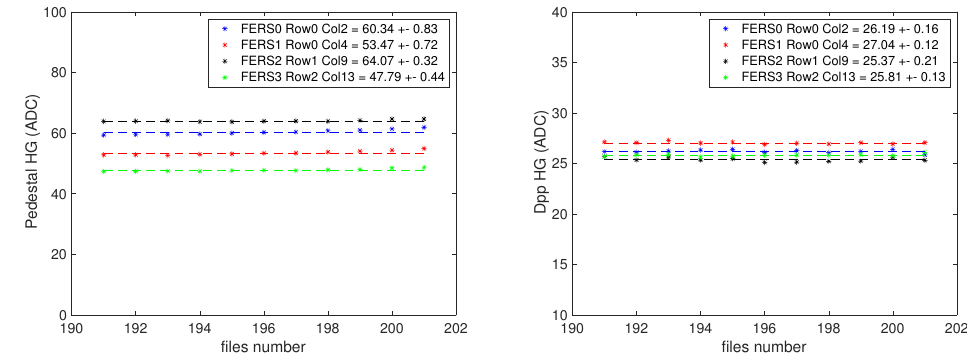
Figure 5. Baseline (on the ( left )) and peak-to-peak difference (on the ( right )) measured for one SiPM per each readout board during a series of consecutive runs used in the data analysis. These plots refer to the DESY test beam